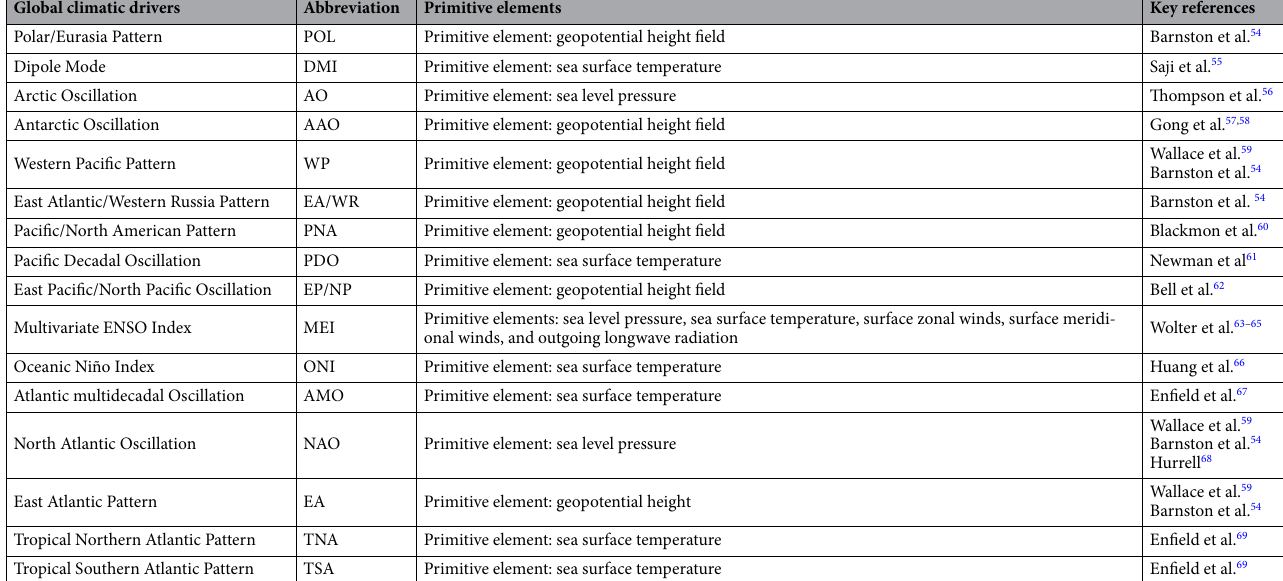
Table 3. Description and key references of sixteen global climatic